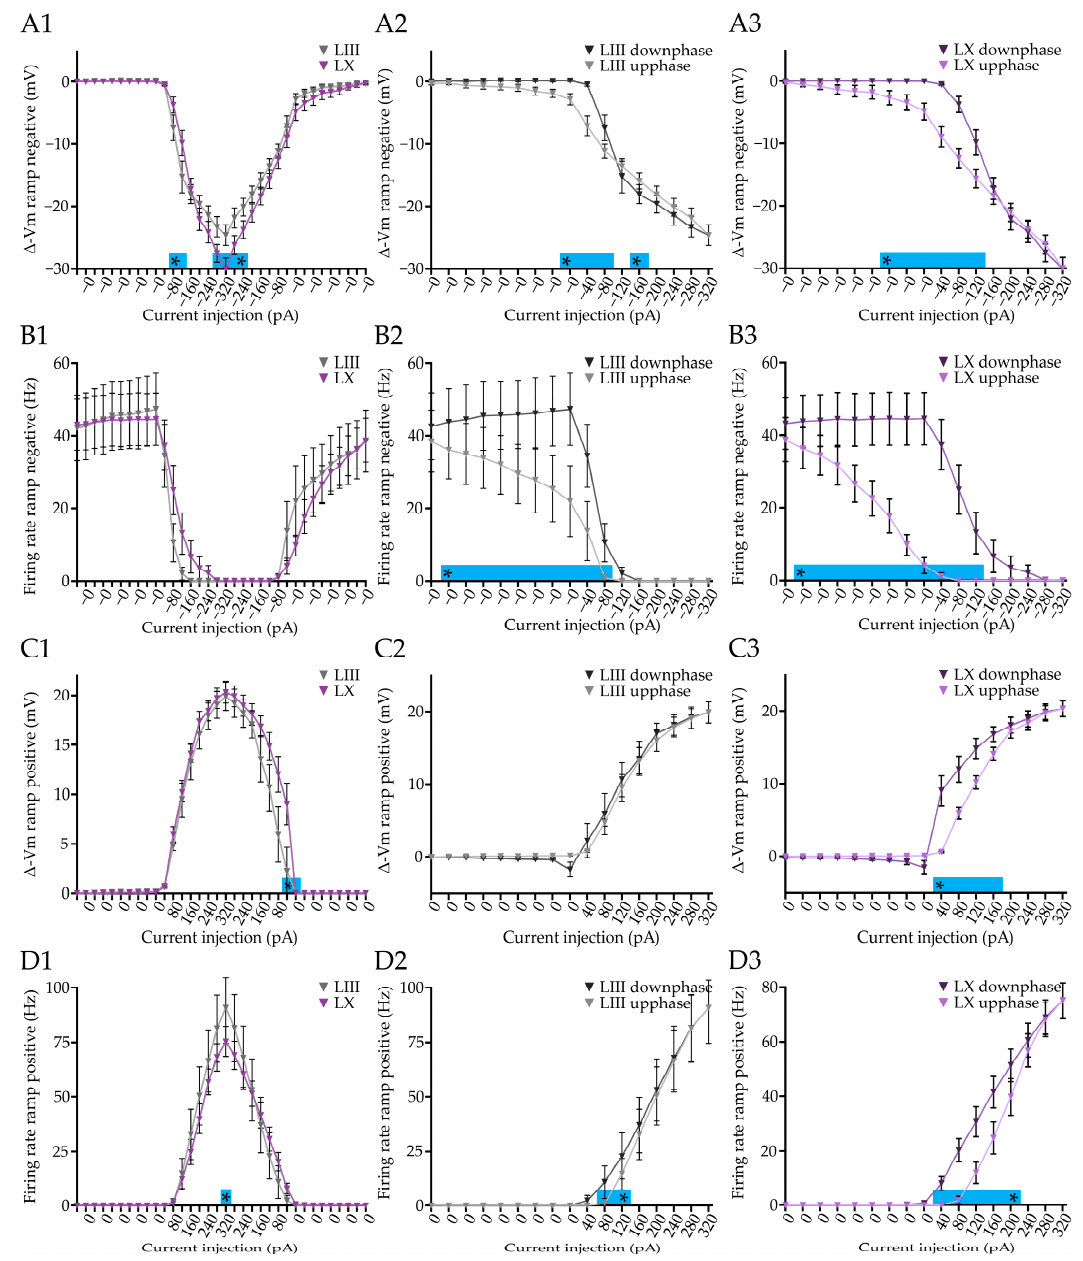
Figure 6. History-dependent current integration in Purkinje cells of juvenile mice. ( A ), Responses of subpopulations of PCs in juvenile mice (P15–17) to negative current ramps starting from a resting membrane potential of − 55 mV ( A1 ). Comparison of the downphase and the upphase for LIII ( A2 ) and LX ( A3 ) PCs. ( B ), Similar to ( A ), but now for the firing rate. In ( A2 , A3 , B2 , B3 ) significant differences indicate that the voltage response and firing, respectively, are dependent on the previous state, and thus history-dependent. ( C1 , C2 , C3 ), Plots of voltage change induced by positive current ramps starting from − 65 mV, comparing LIII and LX ( D1 ) and the upphase and downphase for juvenile LIII ( D2 ) and LX ( D3 ) PCs. € , Similar to ( D ), but now for the firing rate of the recorded PCs. Asterisk denotes p < 0.05. Table S6 for all statistical